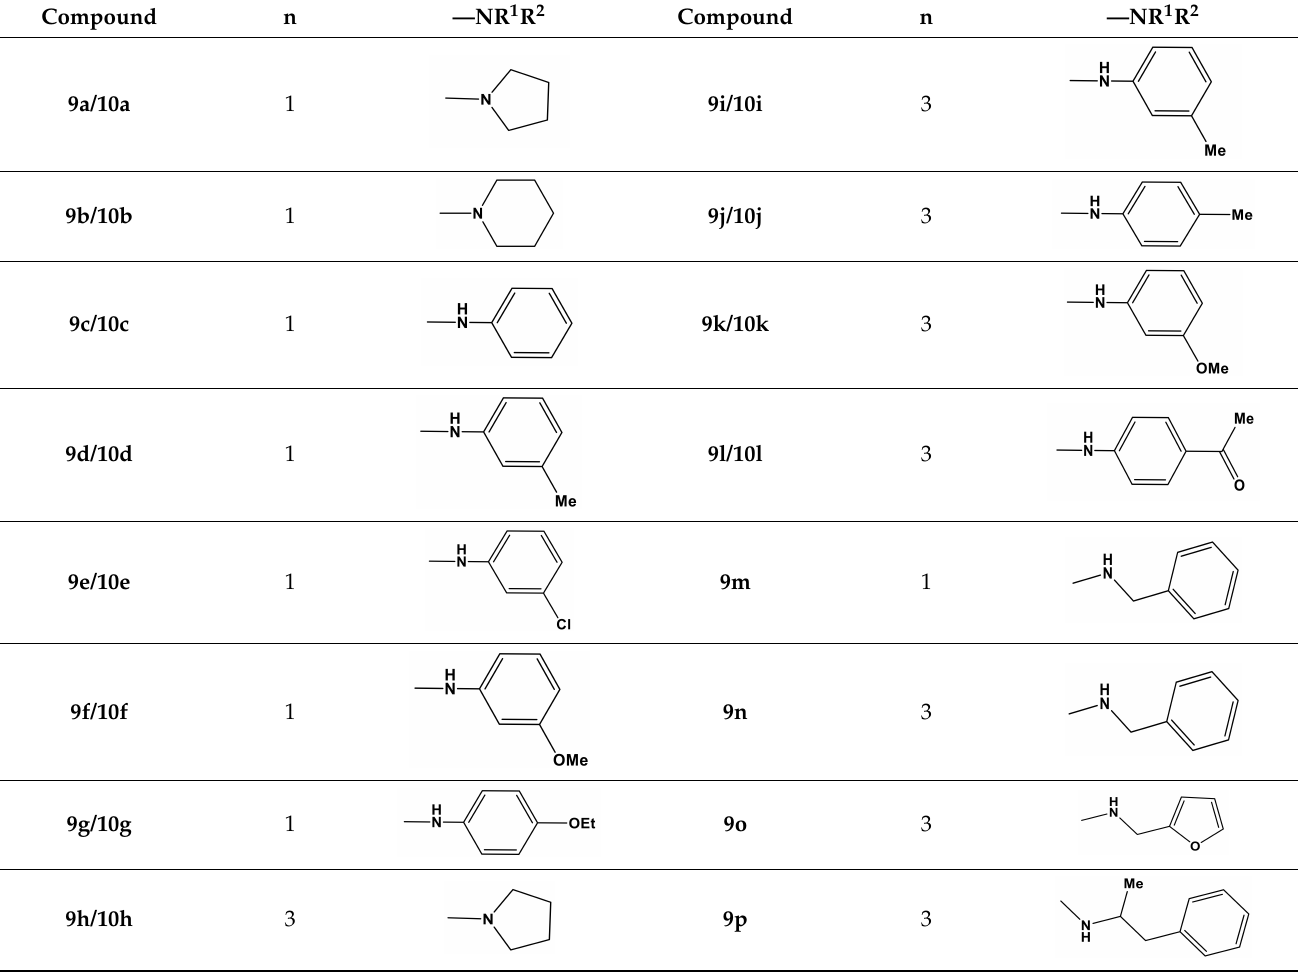
Table 1. Amino-7-isopropyl-2,7-naphthyridines 9a – p and furo[2,3- c ]-2,7-naphthyridines 10a – l